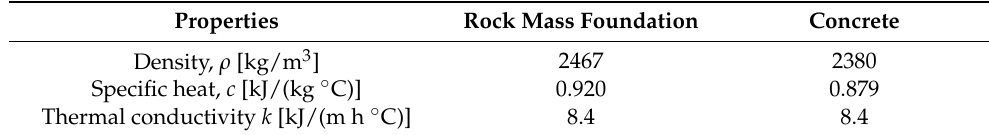
Table 1. Thermal material